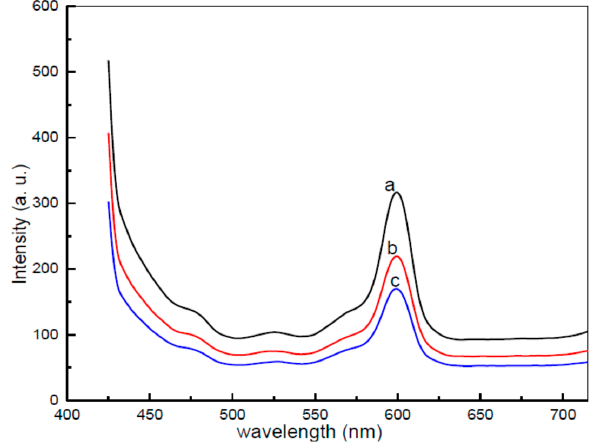
Figure 7. PL spectra of the CdO nanoparticles calcined at 600 °C in different concentration ( a ) for 0.03, ( b ) 0.04, and ( c ) 0.05 g/mL PVP.